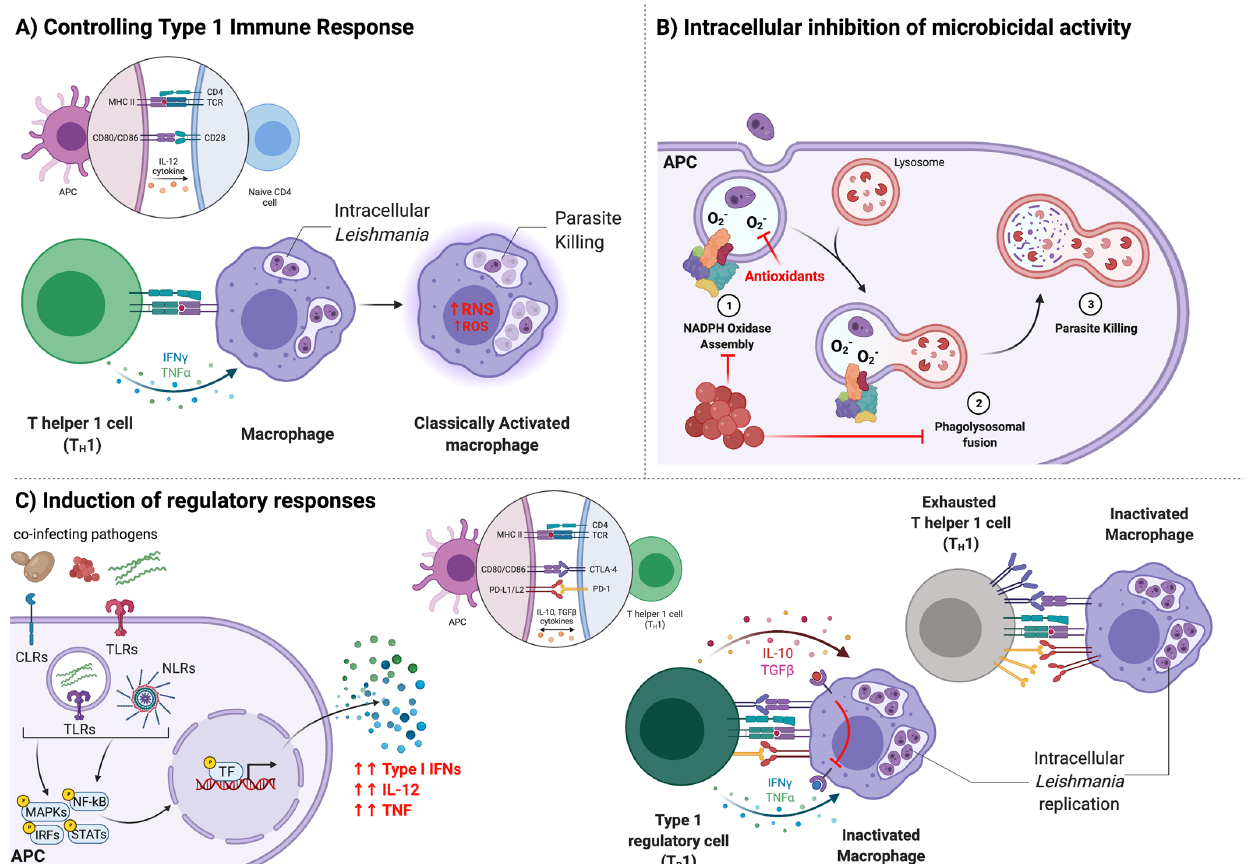
Figure 1. Types of immunological interference with anti- Leishmania responses. ( A ) A controlling Type 1 immune